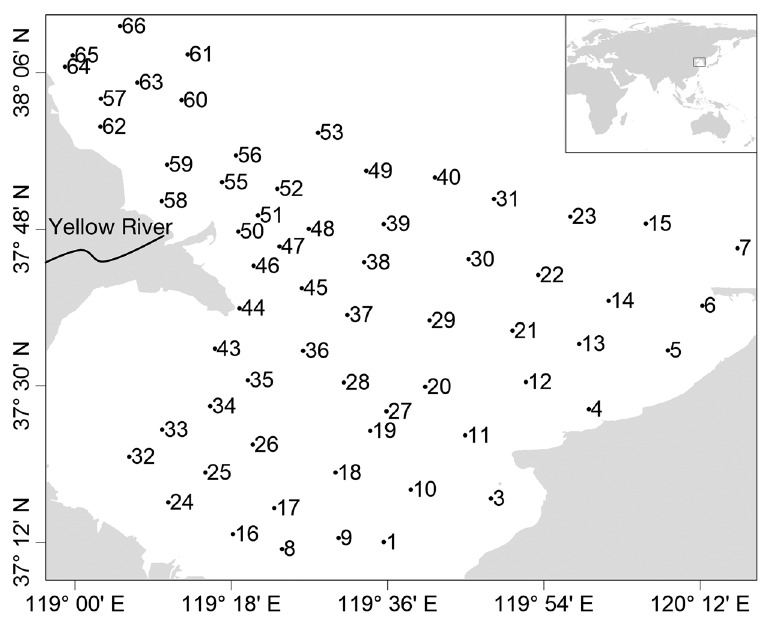
Fig. 1. Sampling stations in Yellow River Estuary